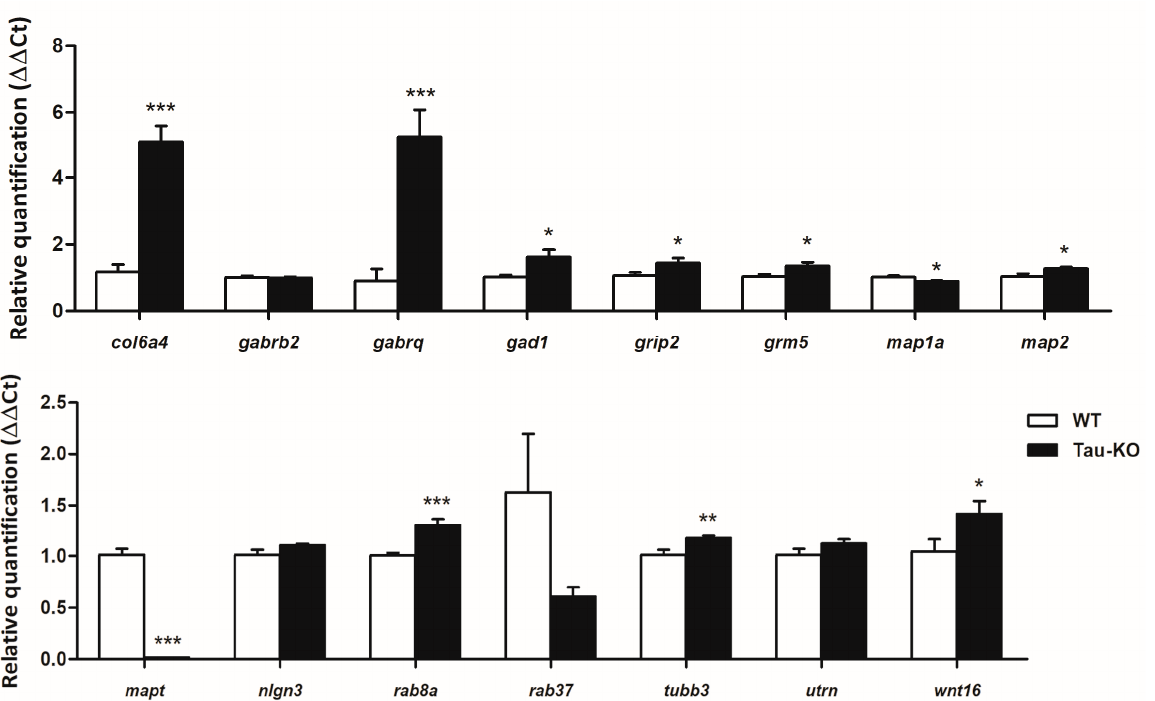
Figure 3. RT-qPCR of the cerebral cortex of tau-KO and WT mice aged twelve months. Tau-KO mice show increased mRNA levels of col6a4, gabrq, gad, grm5, grip2, map1a, map2, rab8a, tubb3 , and wnt16 compared with WT mice. However, the expression of gabrb2, nlgn3, rab37 , and utrn is similar in tau-KO and WT mice. As expected, mapt mRNA expression is 0 in tau-KO mice. * p < 0.05, ** p < 0.01, and *** p < 0.001.